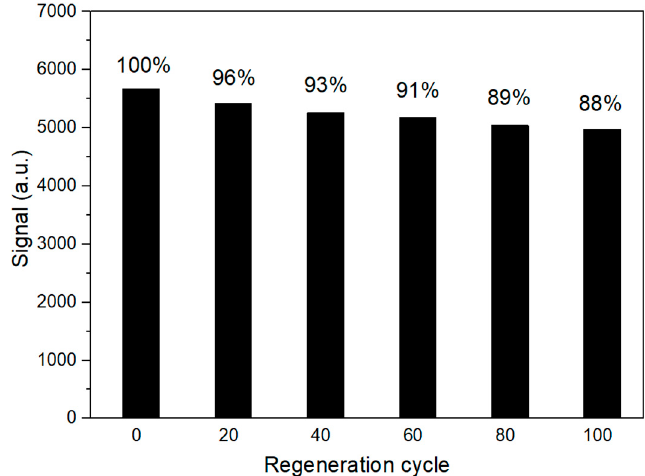
Figure 5. Signals recovery at each twenty regeneration cycles. The signal recovery percentages were indicated in each column.